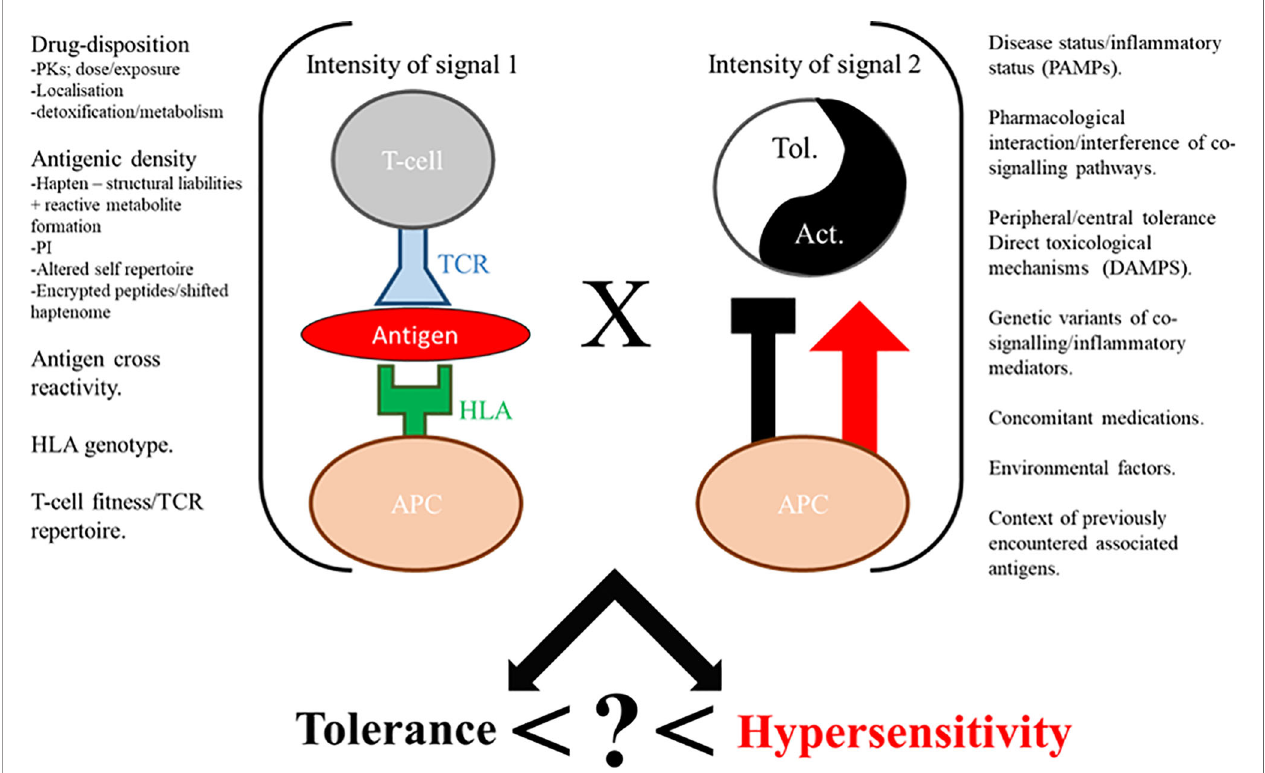
FIGURE 2 | Immunological perception of drugs expressed as a function of signal 1 x signal 2 factors, with an unknown composite (?) yielding hypersensitivity. Tol. = tolerance, Act. =